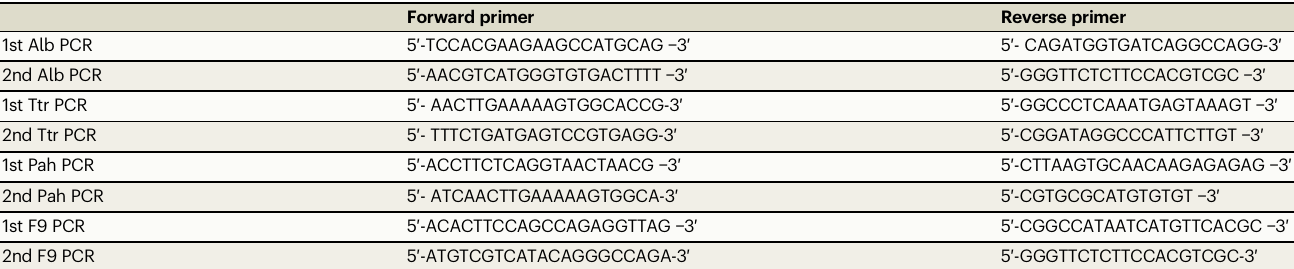
Table 1 | Integration PCR